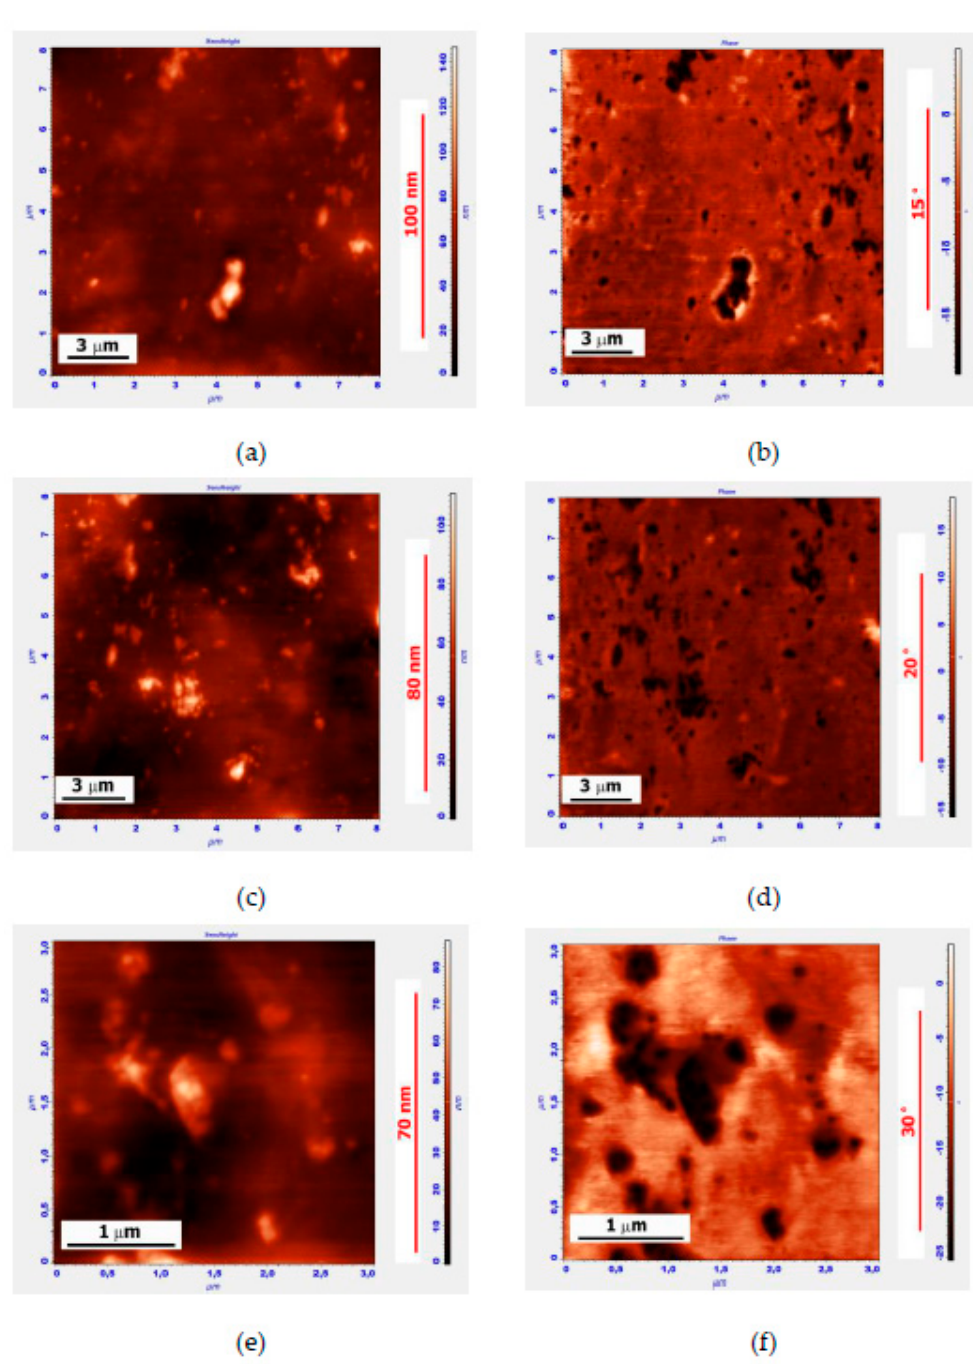
Figure 3. AFM surface images of the MB sample of 85 wt.% Bit-A + 15 wt.% APDDR, obtained 2 days after sample preparation. Topography (left), phase image (right): ( a , b )—8 х 8 μ m, ( a ) Z-coordinate—140 nm; ( c , d )—8 х 8 μ m, ( c ) Z-coordinate—110 nm; ( e , f )—3 х 3 μ m, © Z-coordinate—90 nm.